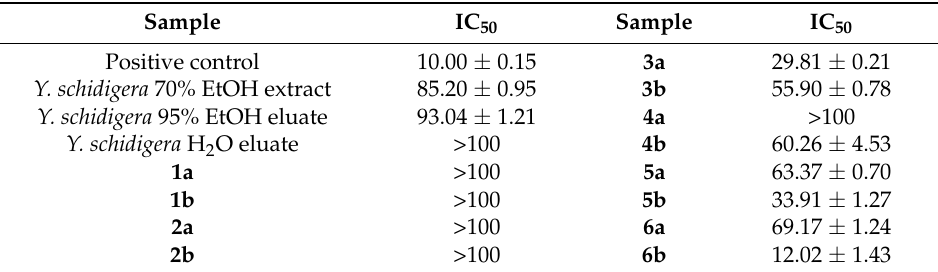
Table 2. The inhibitory effects of Y. schidigera extract, fractions, and 25 R / S -spirostanol saponin diastereomers on the growth of SW620